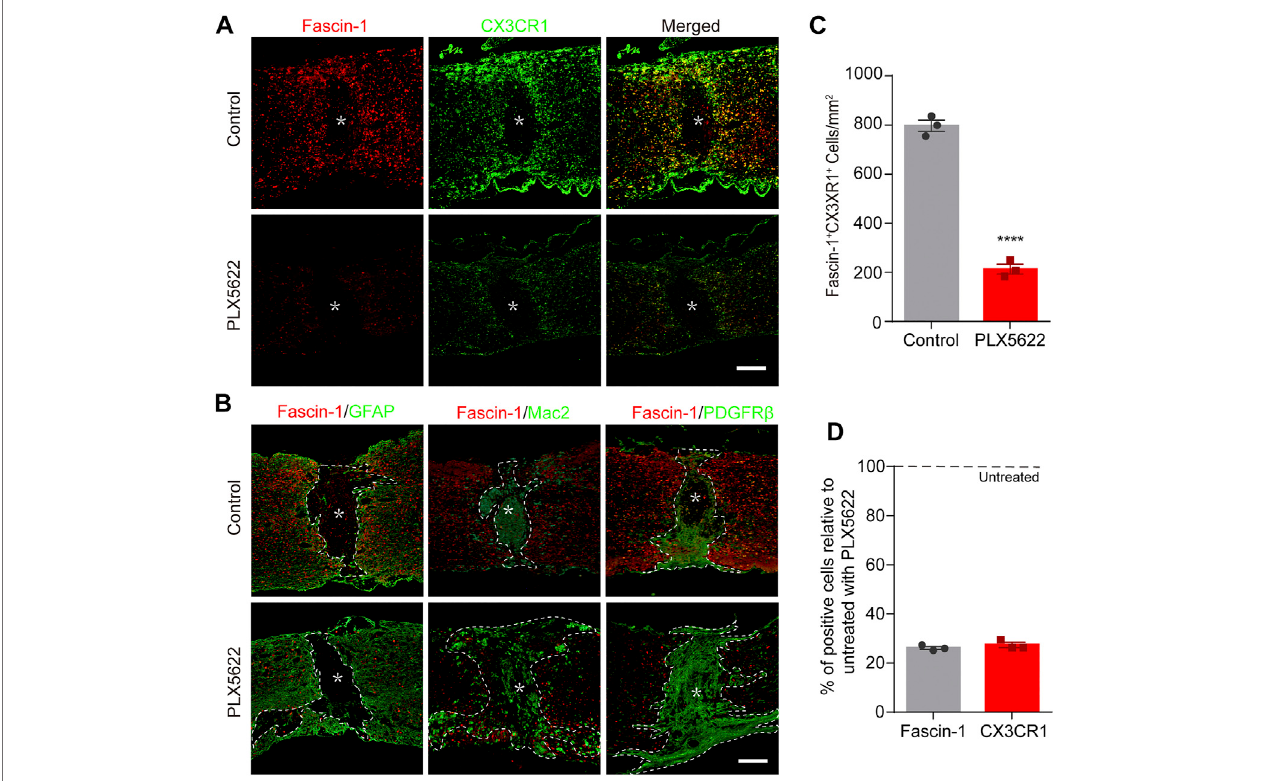
FIGURE 4| The elimination ofmicroglia by PLX5622 treatment results in correspondingly reduced Fascin-1expression, disorganized astrocytic and fi brotic scars, and scattered macrophages in the injured spinal cord at 14 days. (A) Representative fl uorescence images of Fascin-1 (Red) and CX3CR1 (Green) immunostaining showingaconsistentreductioninFascin-1expressionwiththeeliminationofmicrogliaaftertreatmentwithPLX5622comparedtovehicle(control).Theasterisksindicate the lesion epicenter. Scale bar: 500 μ m. (B) Representative immuno fl uorescence images of Fascin-1 (Red) and GFAP (Green), Fascin-1 (Red) and Mac2 (Green), Fascin-1 (Red) and PDGFR β (Green) at the lesion sites of mice treated with vehicle (control) or PLX5622. After the elimination of microglia using PLX5622, the compact GFAP + astrocytic scars and PDGFR β + fi brotic scars are disrupted, with clusters of Mac2 + macrophages spreading outside of the lesion core. The asterisks indicate the lesion epicenter.Thedotted lines delineatetheboundaryaround thelesioncore.Scalebar:500 μ m. (C) Quanti fi cation ofthenumberofFascin-1 + CX3CR1 + microglia in the control and PLX5622 groups ( n (cid:2) 3 per group). The results are expressed as the mean ± SEM. **** p < 0.0001. (D) Percentage of surviving Fascin-1 + or CX3CR1 + cells in the PLX5622 groups relative to that the untreated control groups ( n (cid:2) 3 per group).